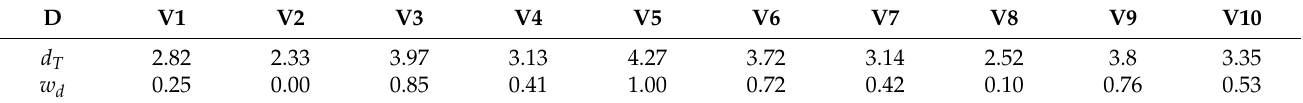
Table 9. Sums of the correlation degree and normalized result of ten variables.